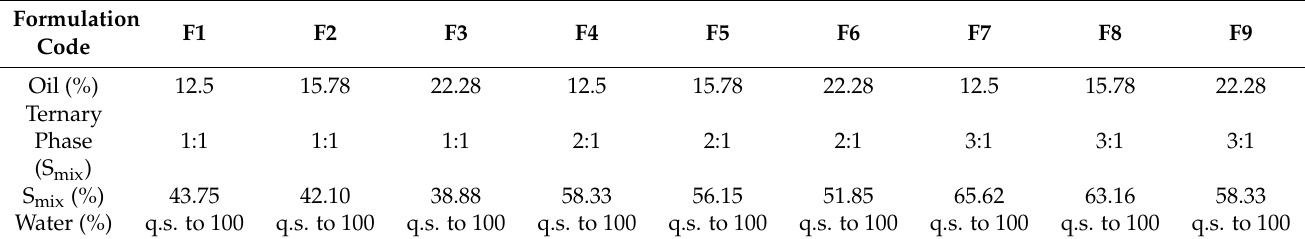
Table 3. Composition of 9 formulation compositions for